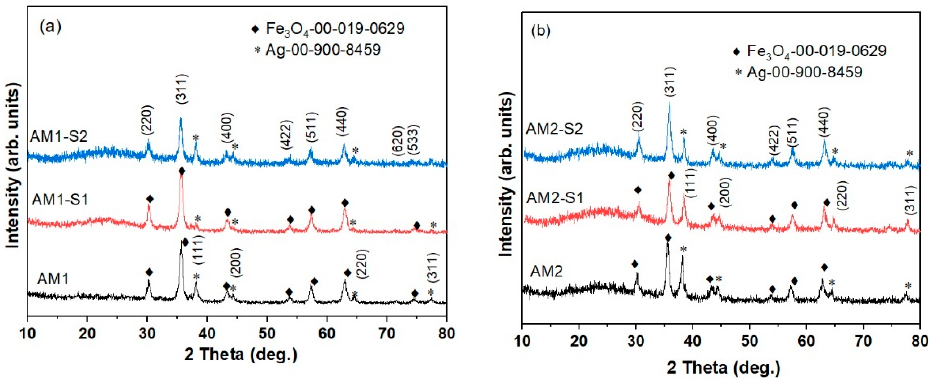
Figure 2. XRD patterns of the ( a ) AM1(-/S1/S2) and ( b ) AM2(-/S1/S2) samples